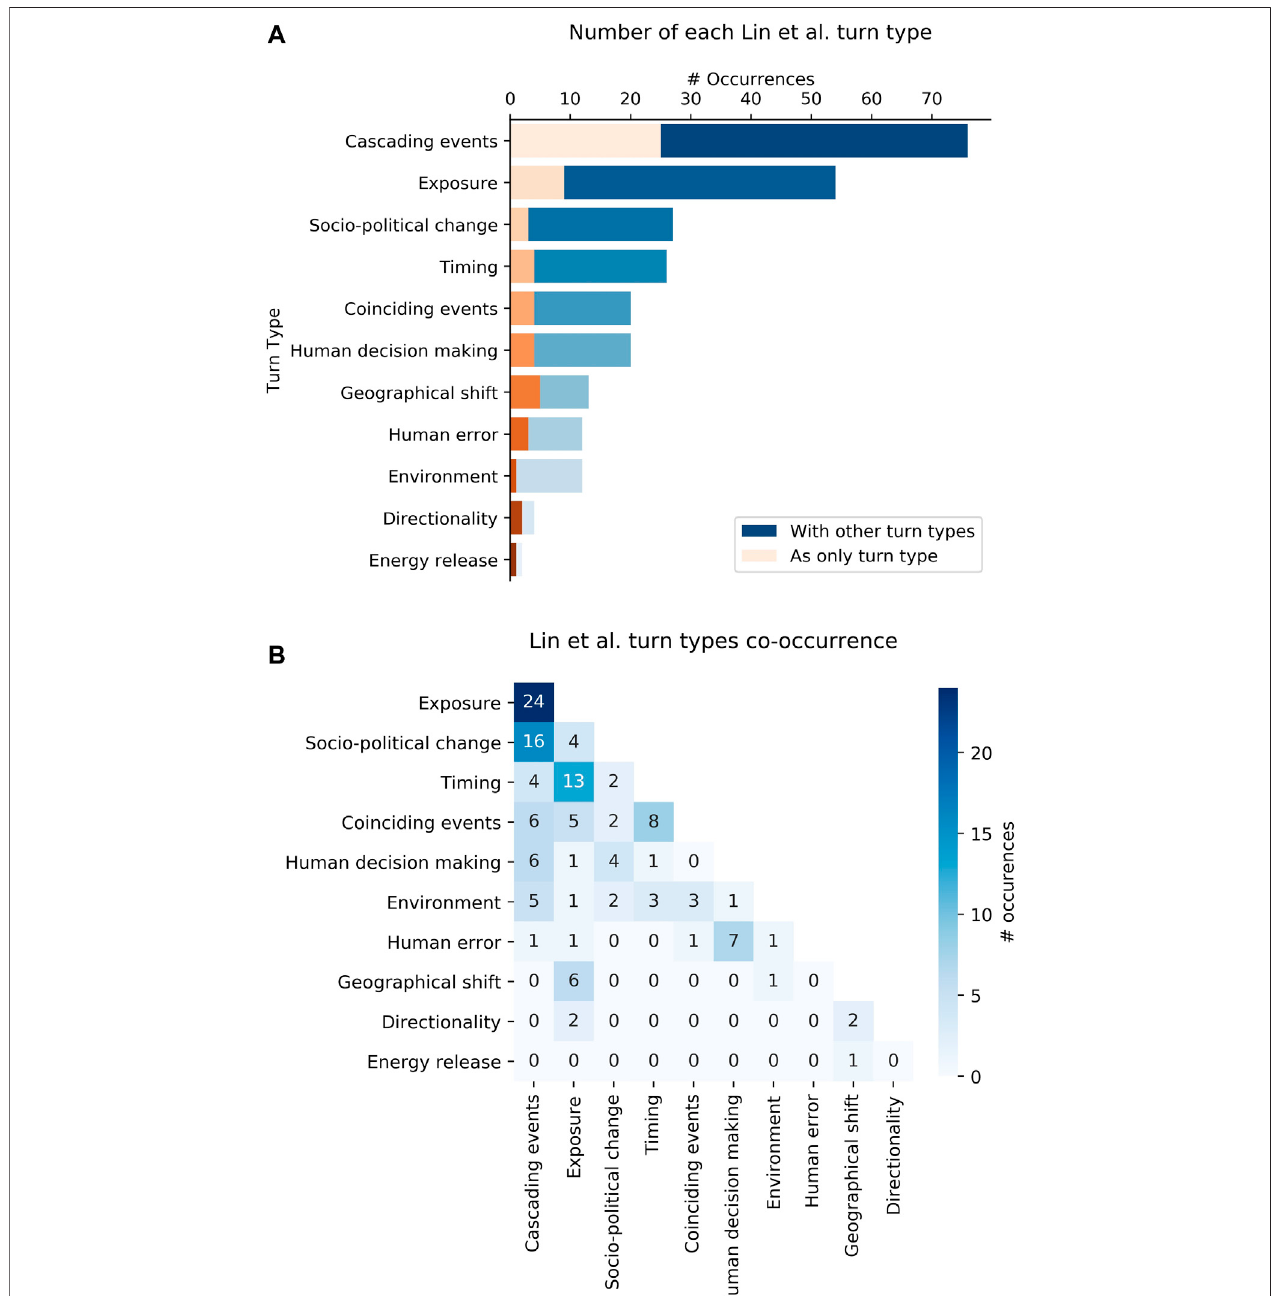
FIGURE 7 | Lin et al. (2020) turn type (co-)occurrence. (A) Frequency of different turn types proposed by Lin et al. (2020). Orange bars show the number of turns coded with only that turn type, blue bars show the number of turns coded with that turn type and one or more other turn types. (B) heatmap showing co-occurrence of Linetal.(2020)turntypes.Numbersandshadingshowthenumberofinstancesofeachco-occurrence(notethattheseco-occurrencescouldrepresentoverlapsofjust these two turn types or these two turn types with a third type i.e., the sum of the values corresponding to a particular turn type need not be equal to the size of the blue bar in (A) .